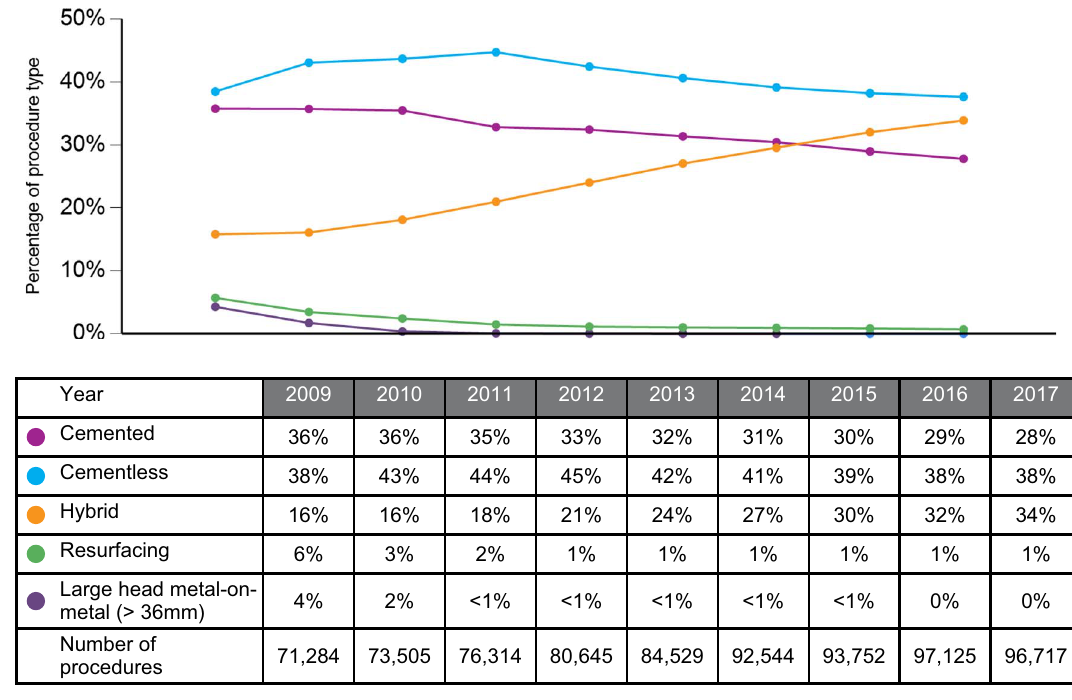
Figure 2. Types of prostheses used for primary THA in England, Wales and Northern Ireland. National Joint Registry (NJR). Types of primary hip replacements undertaken [Internet]. 2018. Available on: